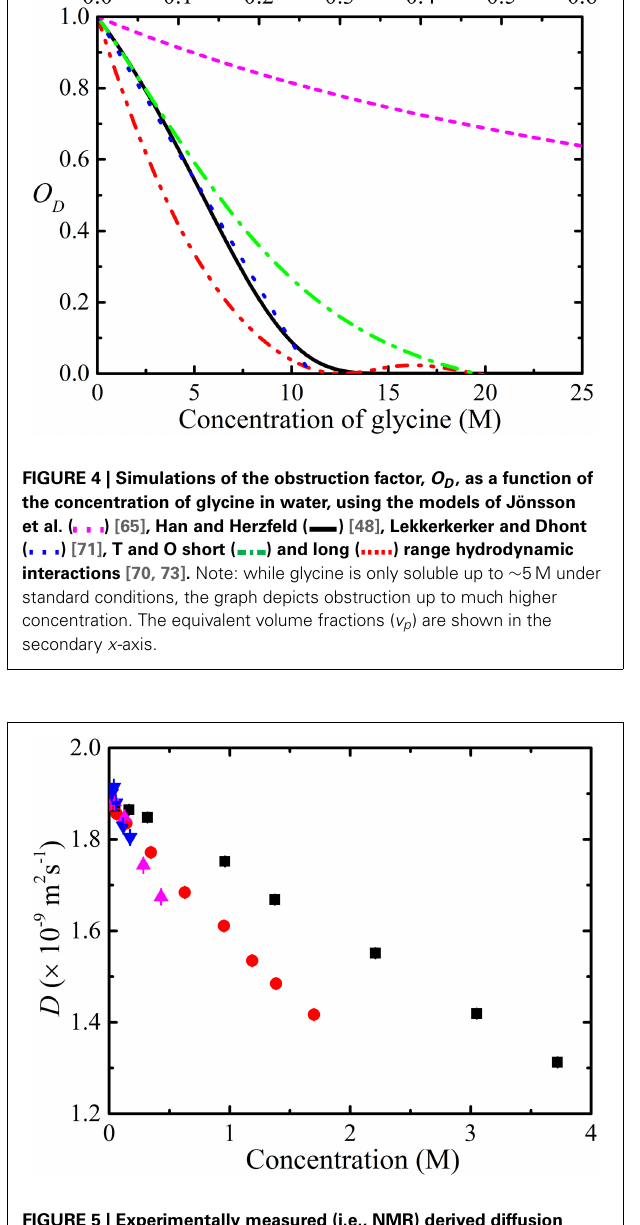
FIGURE 3 | Mole fraction plots of alanine aggregate species in 0.2 ( ) and 1.669M ( ) solutions calculated from the isodesmic model (i.e., Equation 11) with K e = 1 . 39 (equilibrium constant from Table 1). The simulations reveal that large oligomers are present at high concentrations.